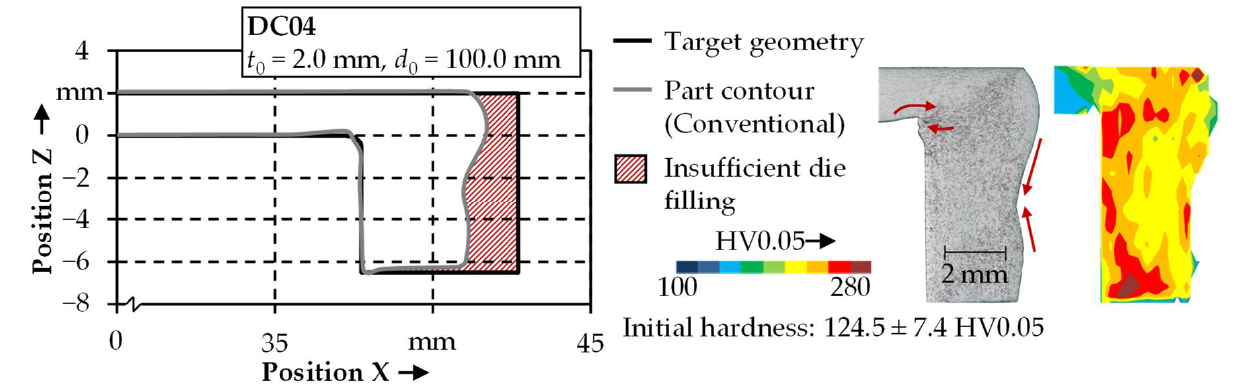
Figure 6. Experimental results obtained with a conventional blank.